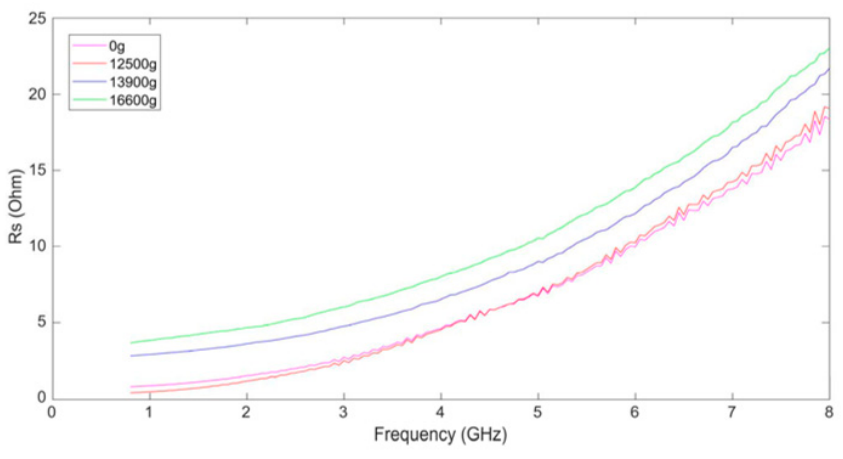
Figure 12. The series resistance of the inductor coils.